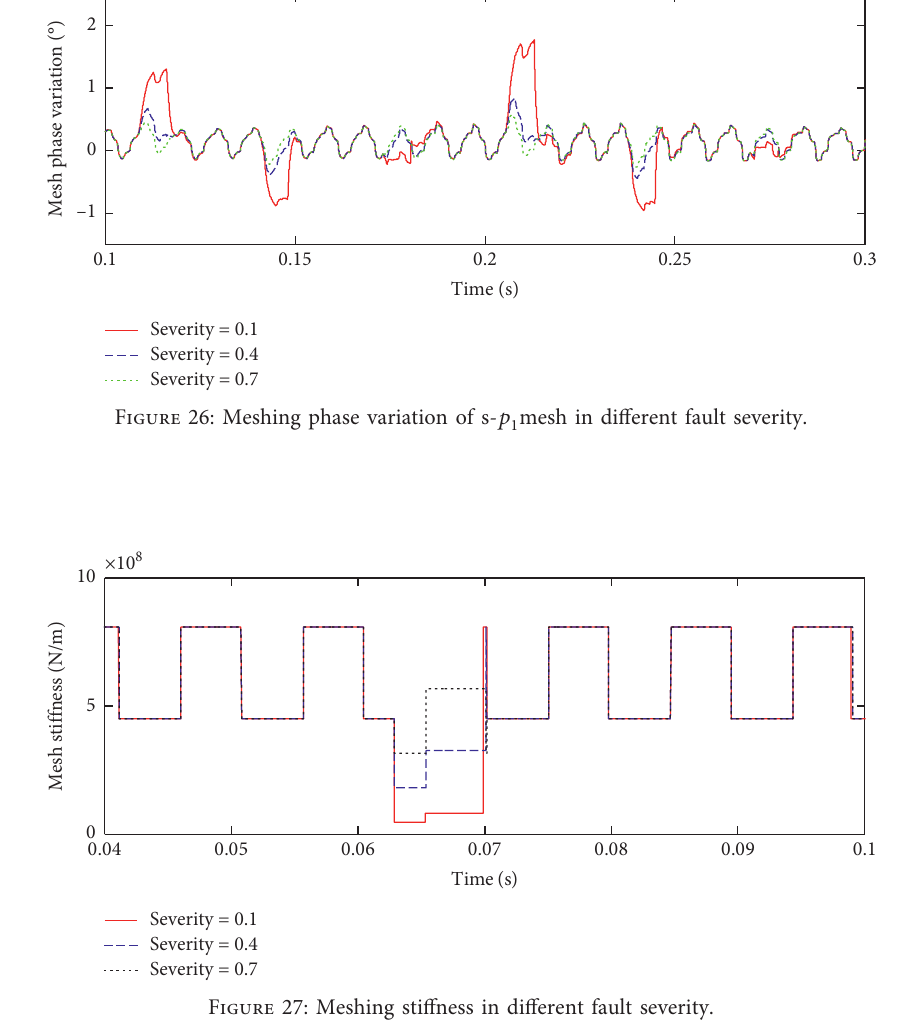
mesh in constant and time-varying pressure angle. 1